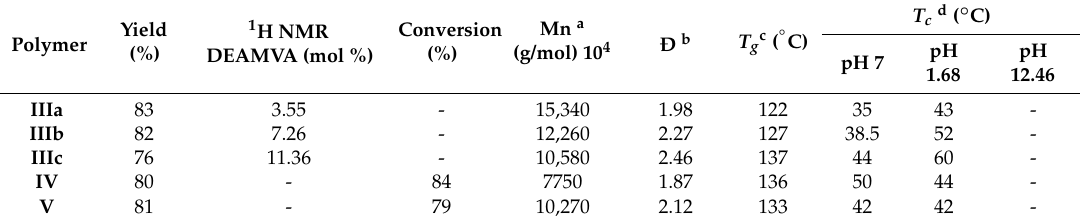
Table 1. Yield, composition, conversion, average molecular weight, polydisperisity, and glass